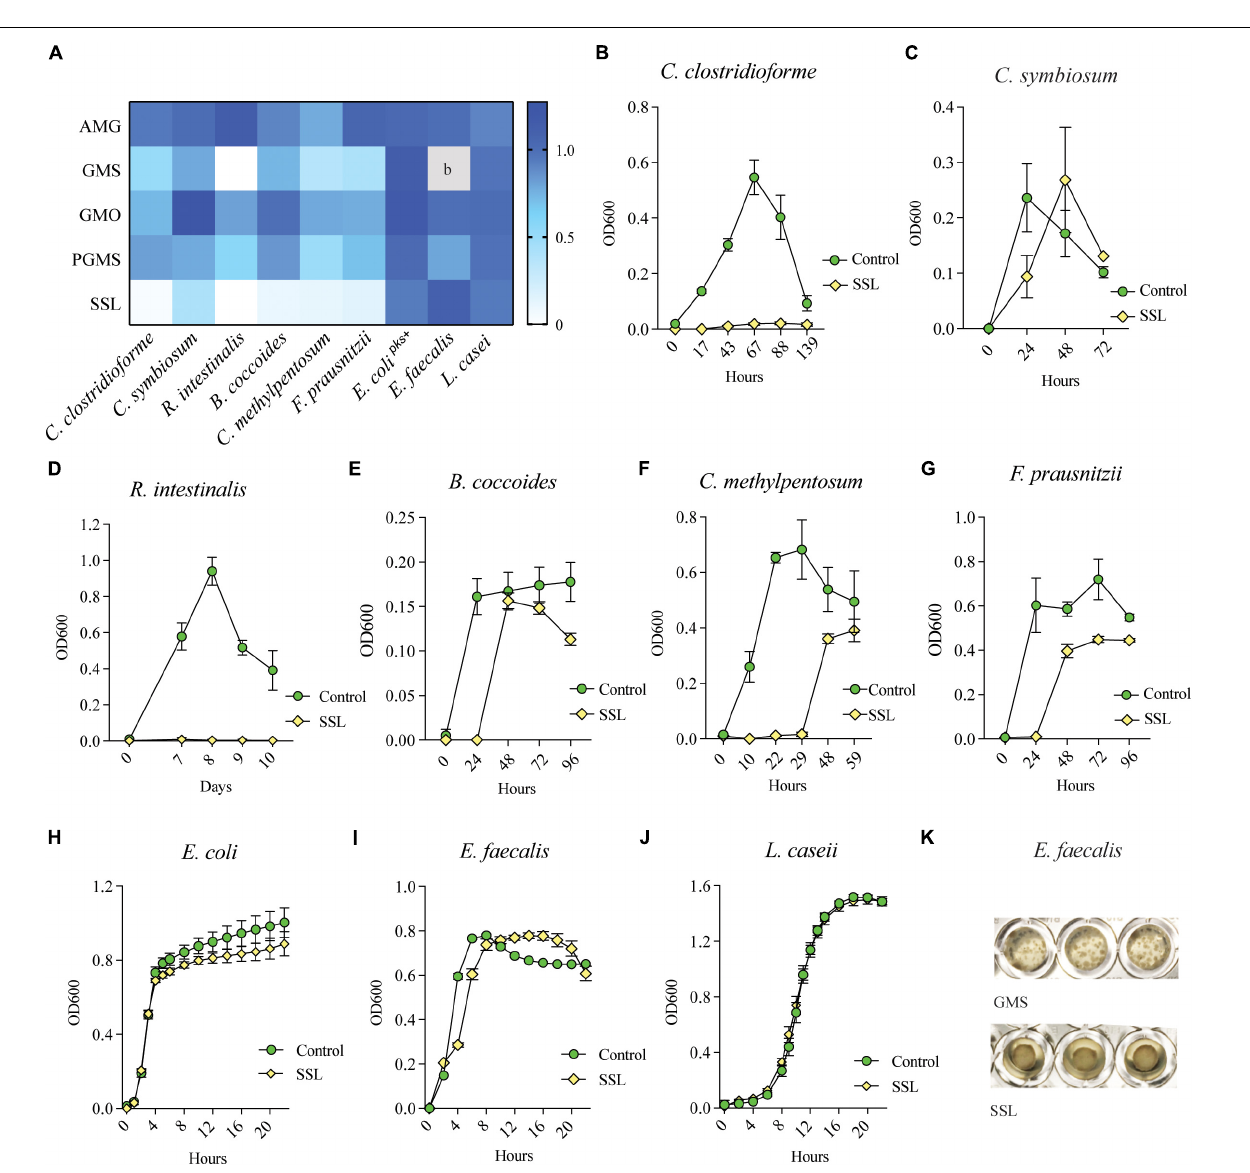
FIGURE 2 | SSL inhibits growth of Clostridial species in monoculture. (A) Heatmap illustrating the sensitivity of Clostridial species to emulsifiers GMS, PGMS and SSL as compared to control organisms E. coli , E. faecalis and L. casei . 0 = emulsifier inhibited growth, 1 = growth equal to control culture. b = E. faecalis formed a biofilm in response to GMS in all experiments (technical replicates n = 6, biological replicates n = 3–4). Colors represent the mean ratio of three biological replicates ( n = 15). (B–G) Representative bacterial growth curves show that SSL is inhibitory to all tested Clostridial species, and potentially bactericidal to C. clostridioforme and R. intestinalis . (H–J) Control organisms E. coli , E. faecalis and L. casei were unaffected by SSL. (K) E. faecalis adhered to well bottom in response to GMS in all experiments and in half of SSL